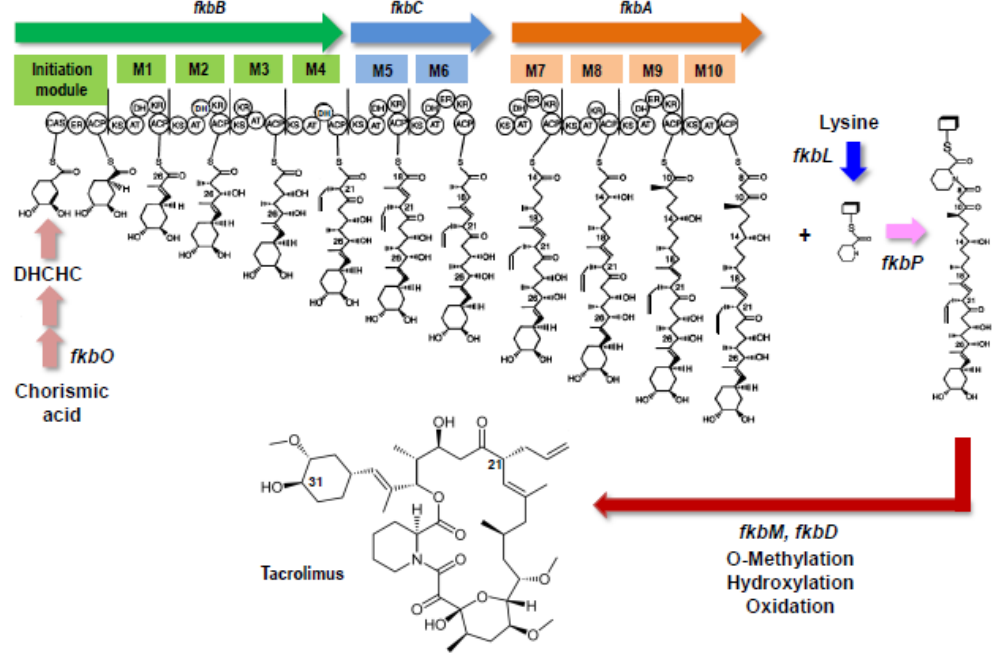
Figure 3. Scheme representing the assembly of the tacrolimus polyketide and the early and late biosynthetic steps. In the upper part the arrows represent the three PKS genes ( fkbA , fkbB , fkbC ) of the cluster. Note that the fkbA gene is physically separated from fkbB and fkbC genes in the fkb cluster (see Figure 2). The modules of the PKSs are boxed and indicated as M1 to M10. Domains in the modules are indicated by circles: ACP, acyl carrier protein; AT, acyltransferase; ER, enoyl reductase; CAS, CoA synthetase; KR, 3-oxoacyl (ACP) reductase; DH, 3-oxoacyl thioester dehydratase; KS, 3-oxoacyl (ACP) synthase. DHCHC: (4R, 5R)-4,5-dihydroxycyclohex-1-enecarboxylic acid. Biosynthetic and late